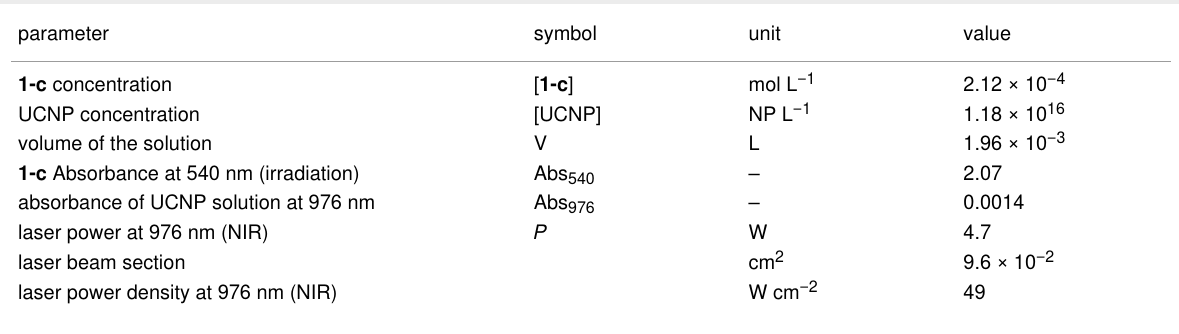
Table 1: Parameters of UCNP used in the photolysis experiment.